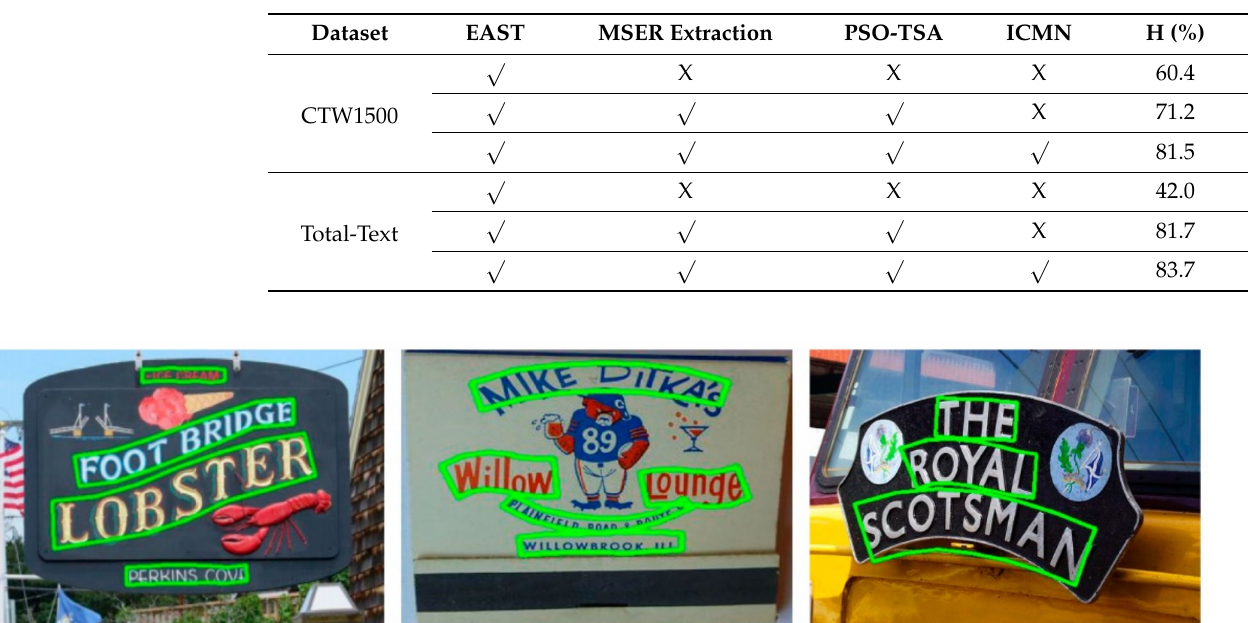
Table 3. The ablation experiment results.